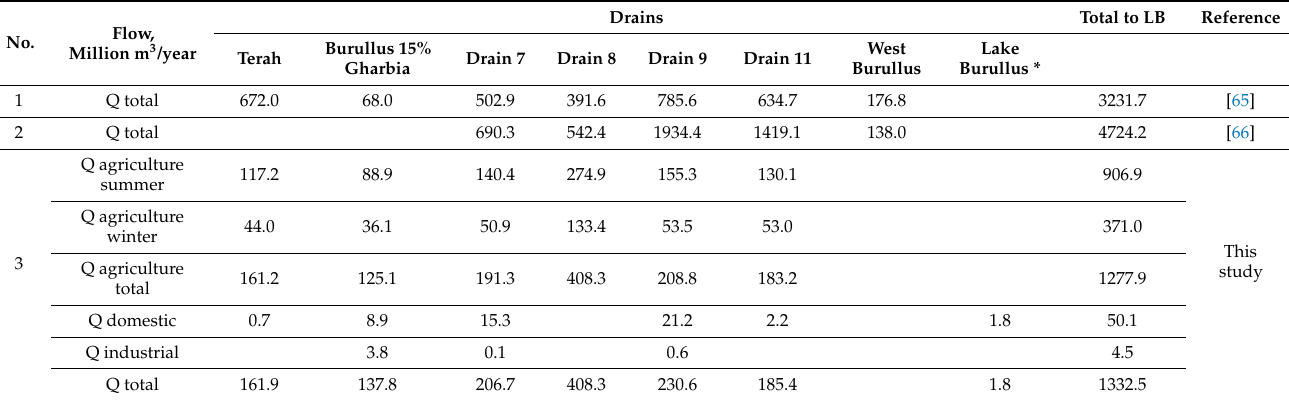
Table 2. Inflows from different activities to drains discharging to Lake Burullus (million m 3 /year).